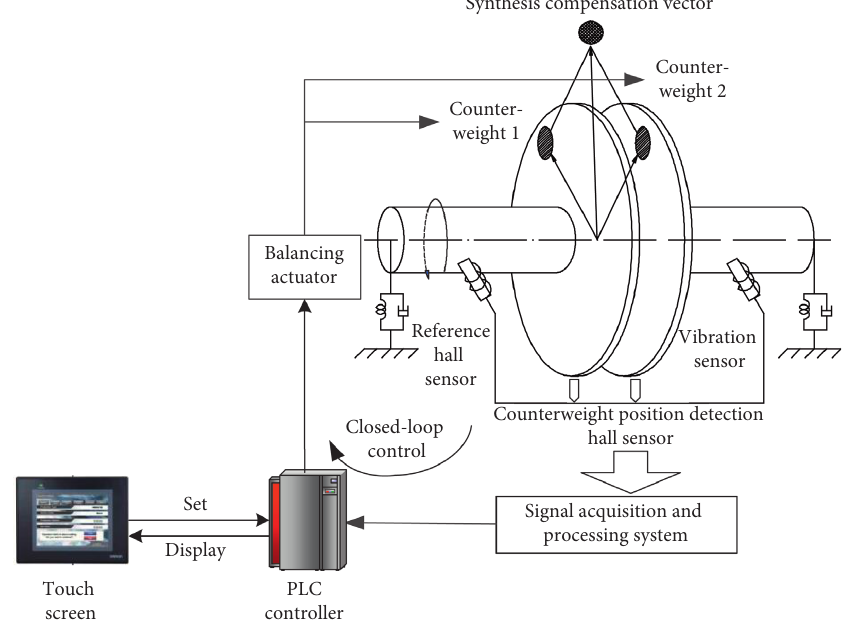
Figure 3: Position detection and control system of the